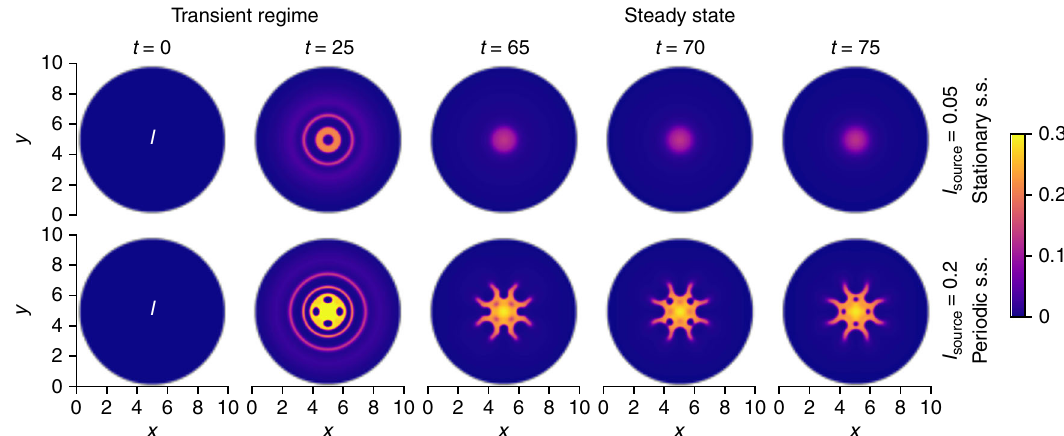
Fig. 3 Time evolution of the density of infected persons I ( x , y , t ) for a local source of infected persons (airport). The time evolution is shown for strong interactions with C si = 3 C sd = − 30 and different in fl ux strengths I source . Initially, one observes radial spreading (transient regime). Later, a steady state is reached, which is stationary for a small in fl ux. A larger in fl ux leads to a periodic regime ( I ( x , y , t ) = I ( x , y , t + n τ ) with n 2 N and period duration τ ≈ 16), involving the formation of a complex oscillating